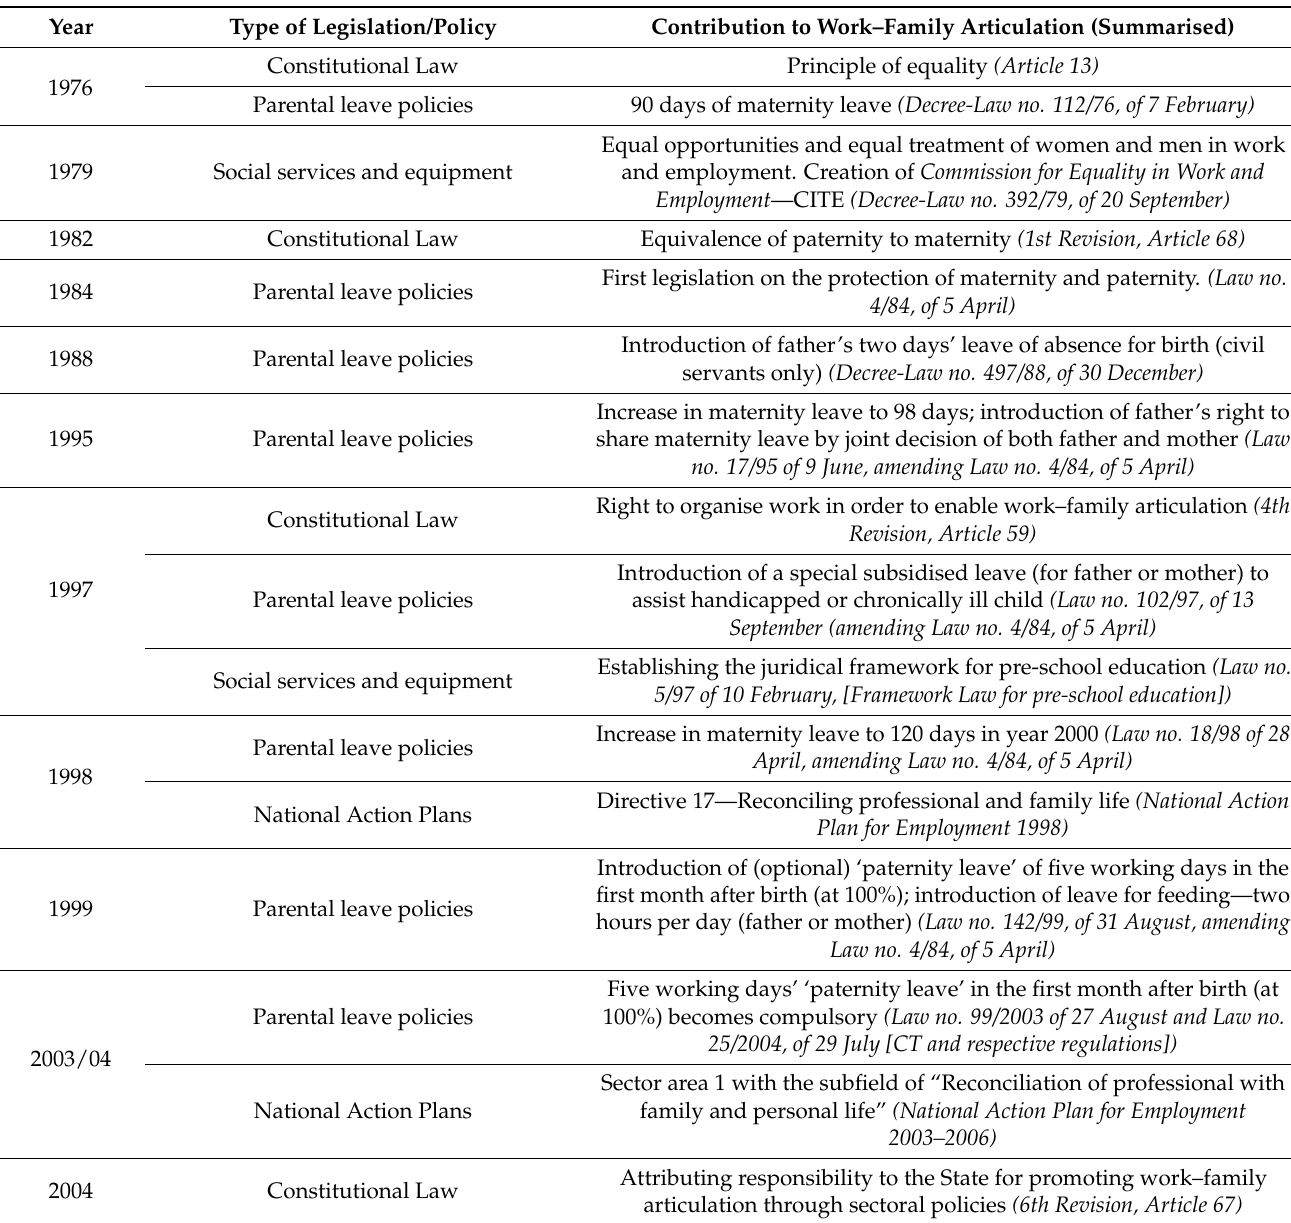
Table 1. Chronology of the relevant legislation/policy within the framework of work–family balance,